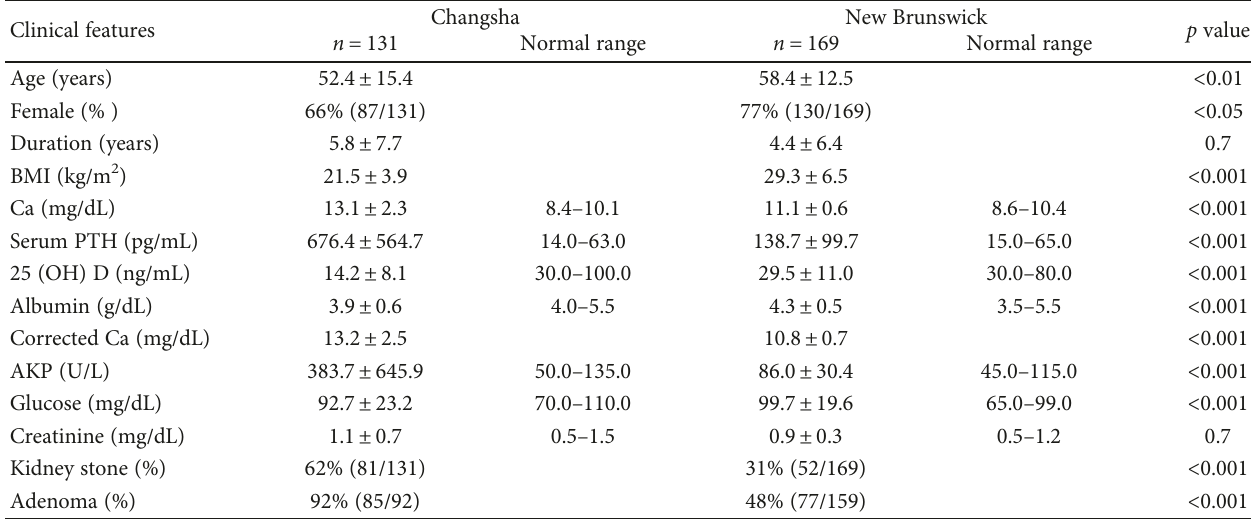
Table 1: Comparison of clinical features of PHPT patients in New Brunswick and Changsha from 2010 to 2016. Clinical features